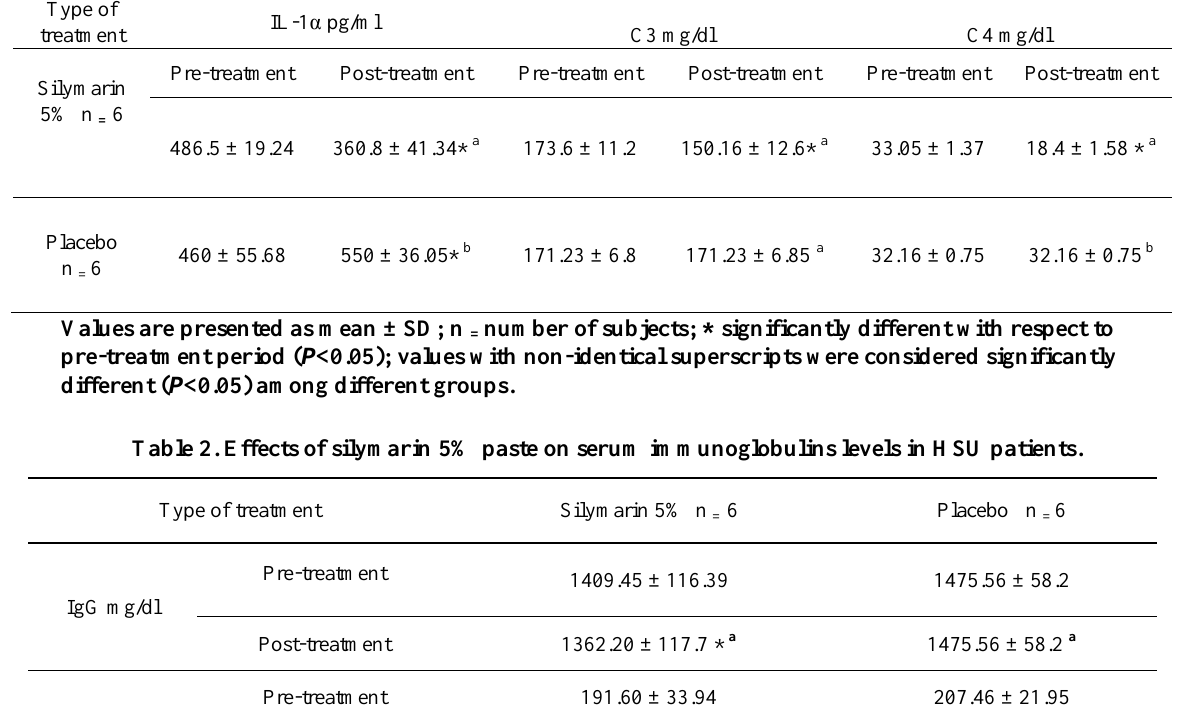
Figure 4. Effects of treatment with silymarin Figure 3. Effects of treatment with paste on the pain score in HLU patients. All silymarin paste on complete pain relief in results are significantly different ( P <0.05) HLU patients.All results are significantly compared to placebo within 3 days. different ( P <0.05) compared to placebo within 3days . Table 1. Effects of silymarin 5% paste on serum levels of interleukin 1-α ( IL-1α ) and the complement proteins (C3 and C4) in HLU patients.